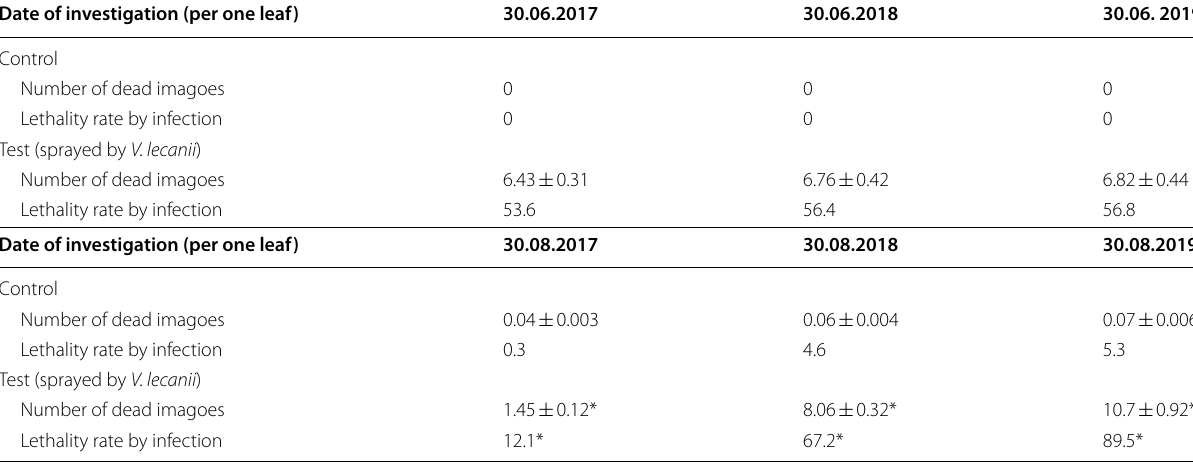
Table 4 Infection and reinfection effects of Empoasca flavescens in 3 years (outdoors) Date of investigation (per one